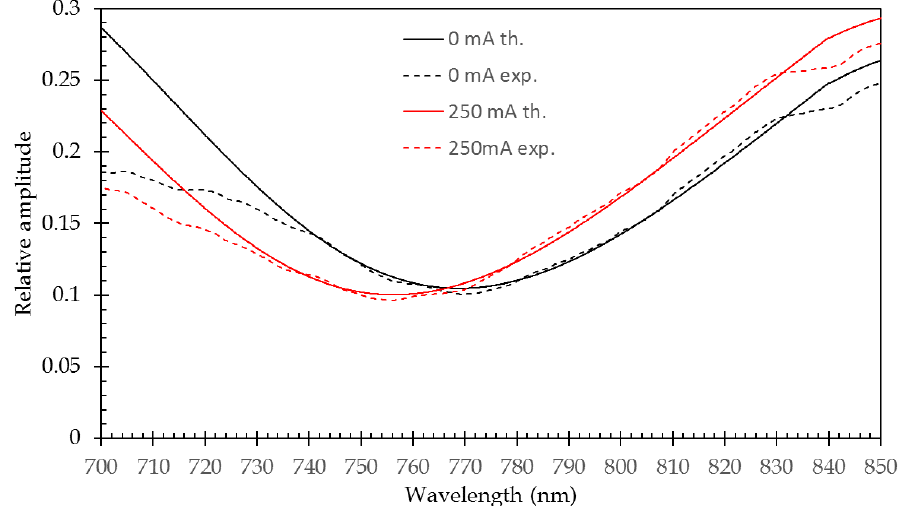
Figure 20. Comparison of experimental and theoretical response curves at 0 and 250 mA current injection levels.